Question: State the chart type depicted above.
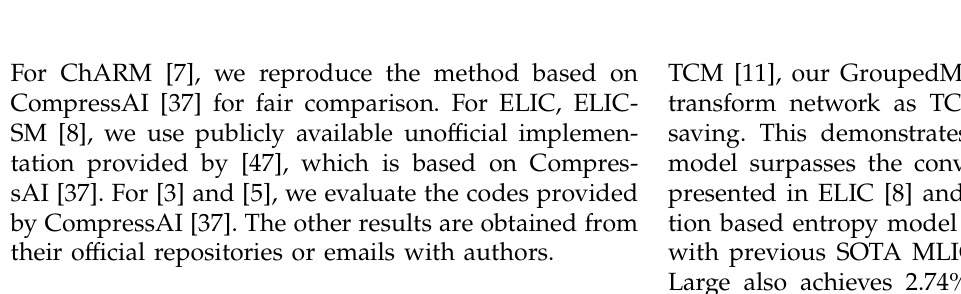
Answer: line